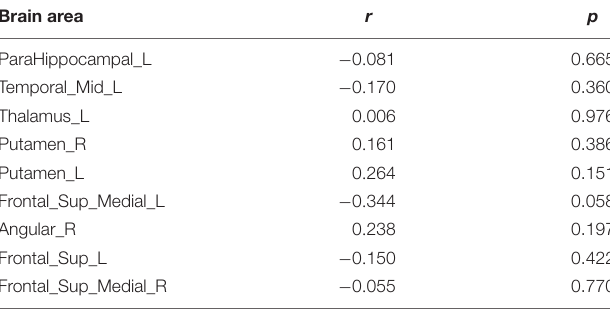
TABLE 5 | Correlation between ReHo value and clinical